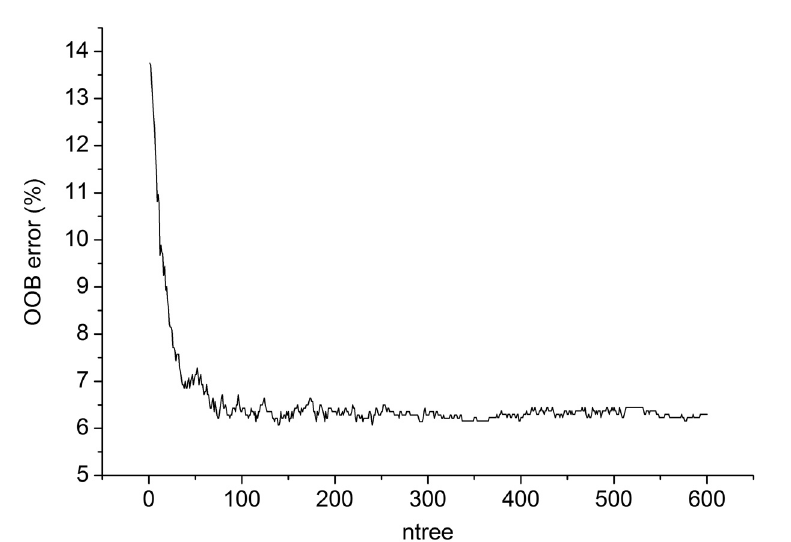
Figure 7. OOB error of Random